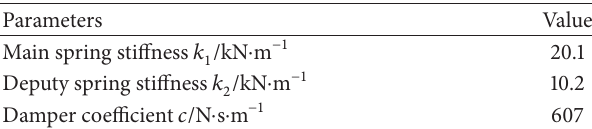
Table 3: Optimal parameters.